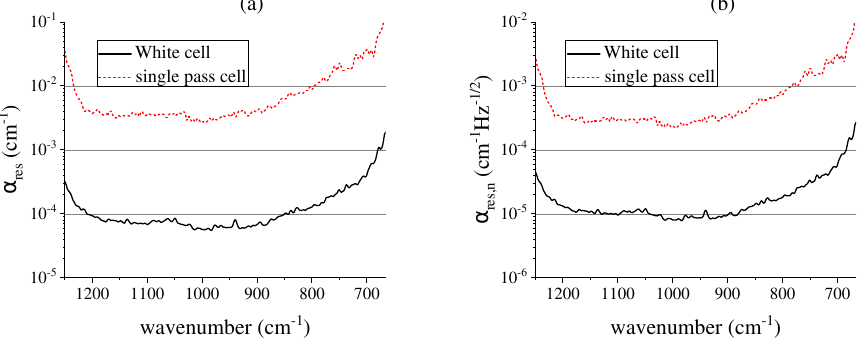
Figure 9. ( a ) Minimum resolvable absorption coefficients α res of both measurement setups; ( b ) Minimum resolvable absorption coefficients α res,n normalized to the acquisition rate of both measurement